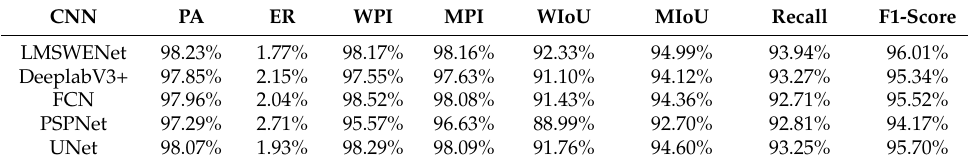
Table 7. Land surface water information extraction accuracy of the